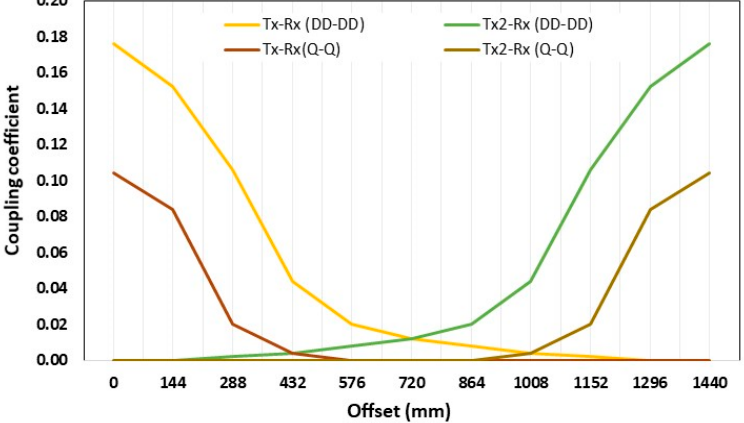
Figure 17. Variation of the coupling coefficient (k) for every step of the Offset in the DDQ–DDQ configuration.